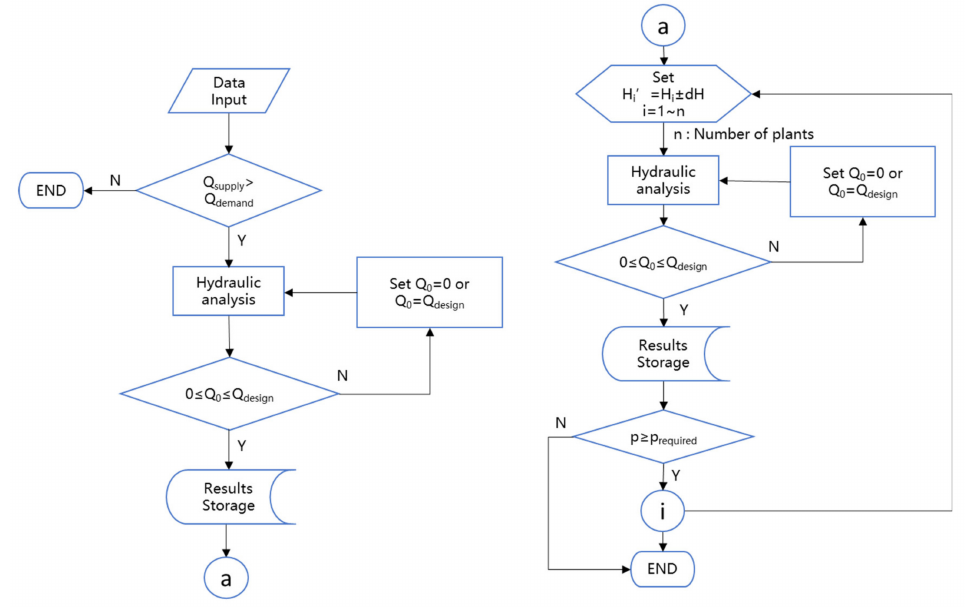
Figure 1. Flow chart of the local search concept optimization